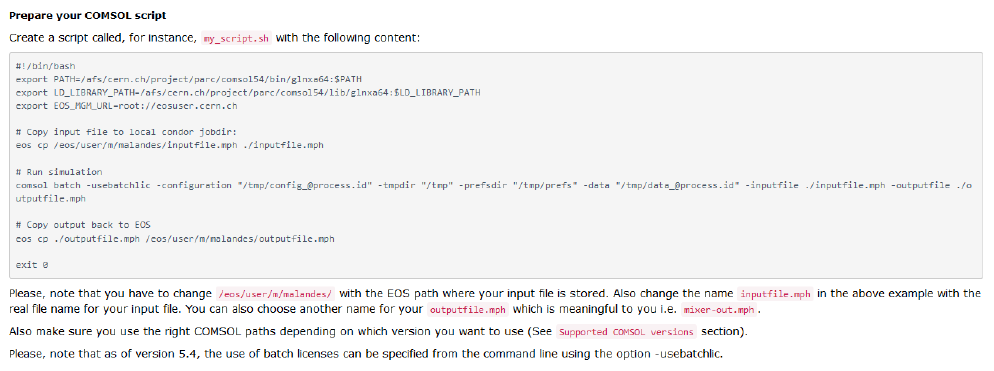
Figure 5. Piece of documentation to submit COMSOL jobs to HTCondor